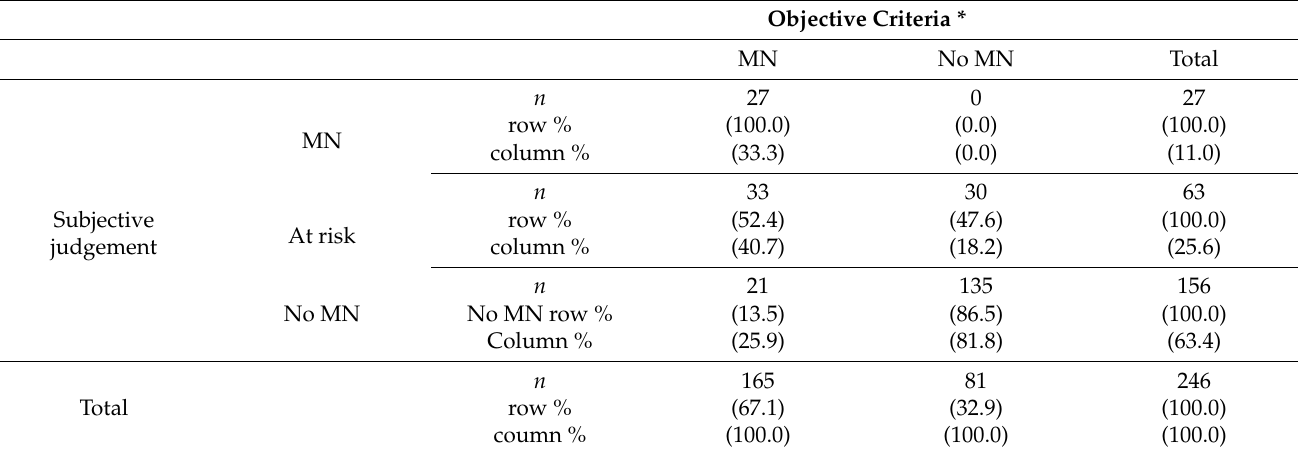
Table A2. Agreement of subjective judgement of nursing staff and objective rating * of malnutrition